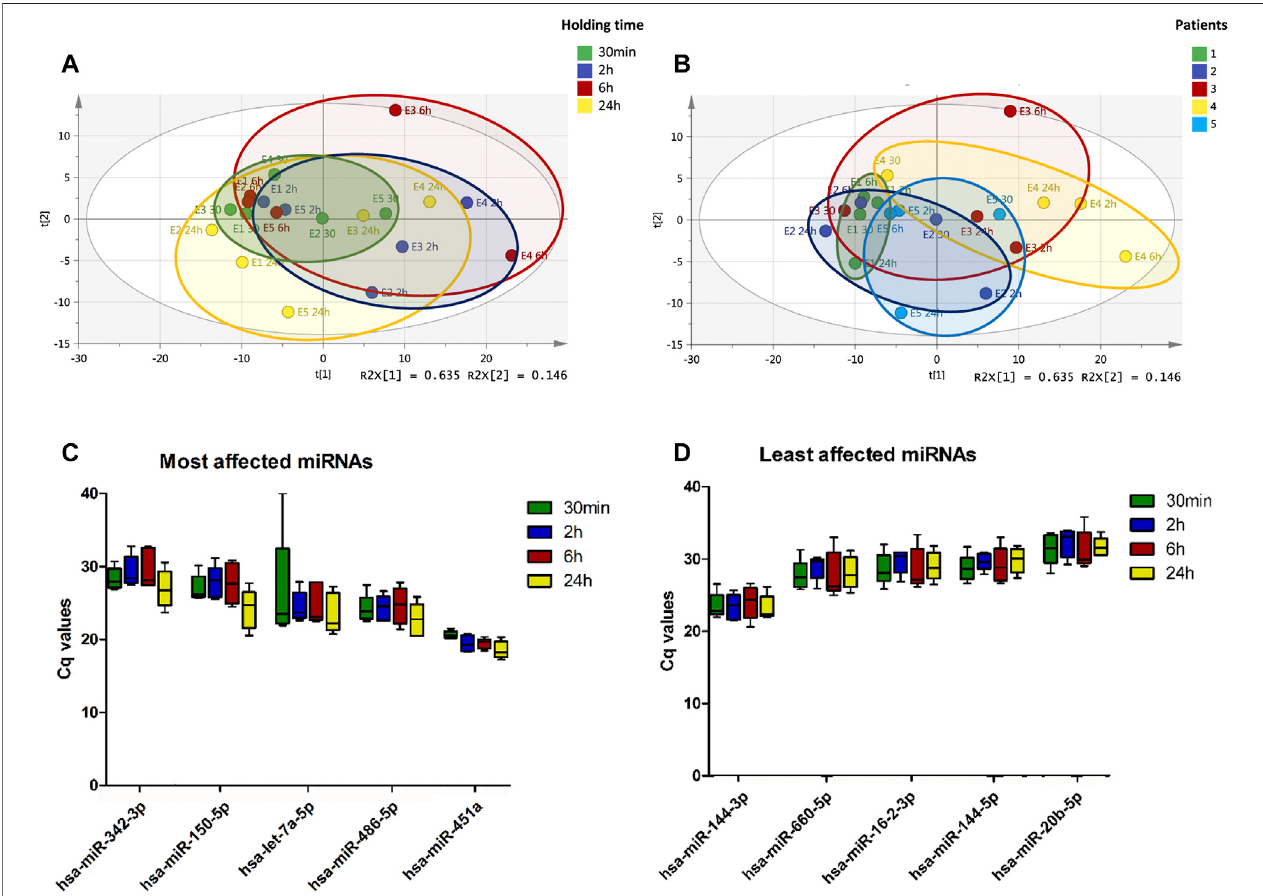
FIGURE2| PlasmamiRNAexpressionpro fi lechangeswithincreasingholdingtime.Wholebloodcollectedfrompregnantwomenwerestoredat4 ° Cfor30 min,2, 6 and 24 h prior to processing for plasma. The expression of plasma miRNAs was determined using RT-qPCR. Principal component analysis (PCA) scores plot of 179 plasma miRNAs colored according to holding time, A 30 min (green), B 2 h (blue), C 6 h (red), and D 24 h (yellow) shows clustering of samples with 30 min holding time (A) . PCA shows increase in variability in the plasma miRNA pro fi les associated with increasing holding time. PCA scores plot of 179 plasma miRNAs colored according tosamples,1to 5,shows that there issample-dependent variability inthe plasma miRNA pro fi le changesassociated withincreasingholding time (B) .Top 10 miRNAs affected by blood holding time (C) and top 10 most stable miRNAs over holding time (D) were identi fi ed using coef fi cient of variation.